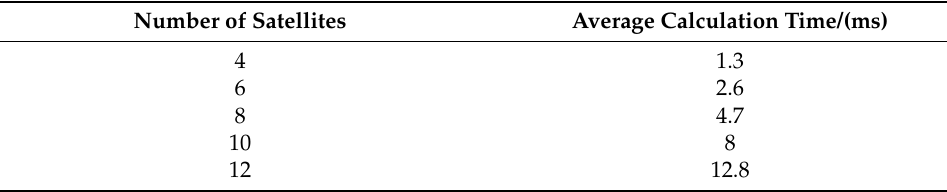
Table 5. The average calculation time of one instance of navigation processing. Number of Satellites